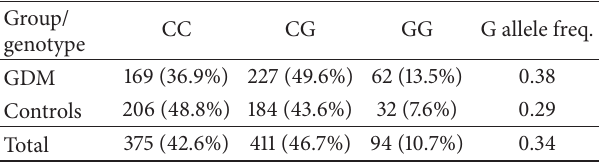
Table 2: Genotypic and allelic frequencies of the MTNR1B